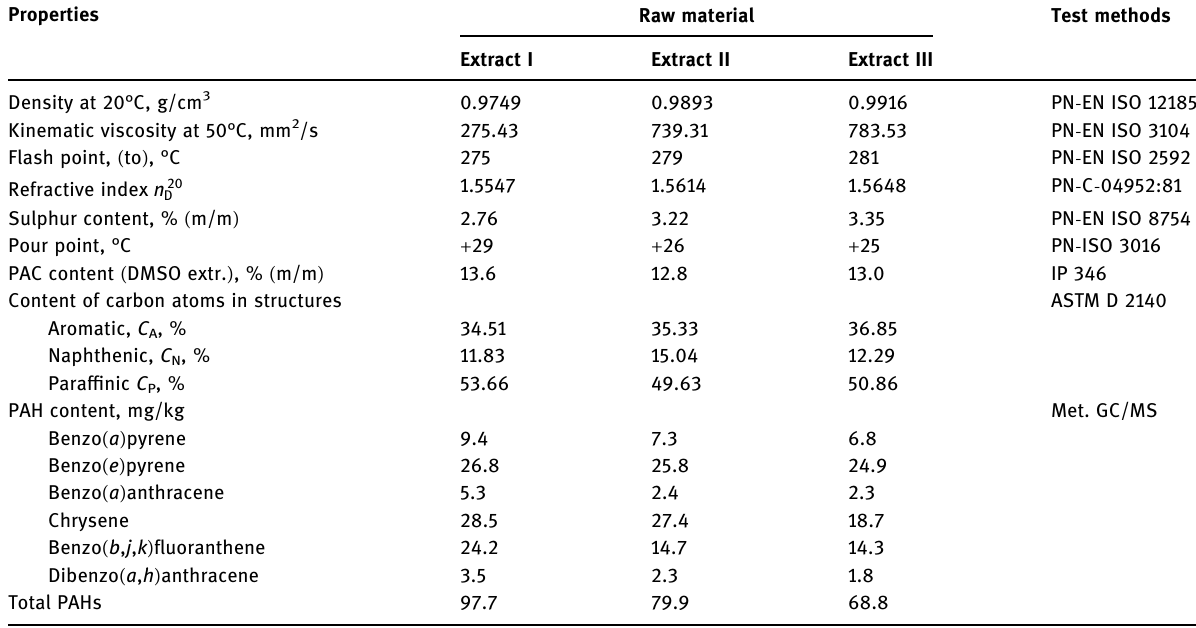
Table 2: Physiochemical properties of raw materials ( heavy extracts